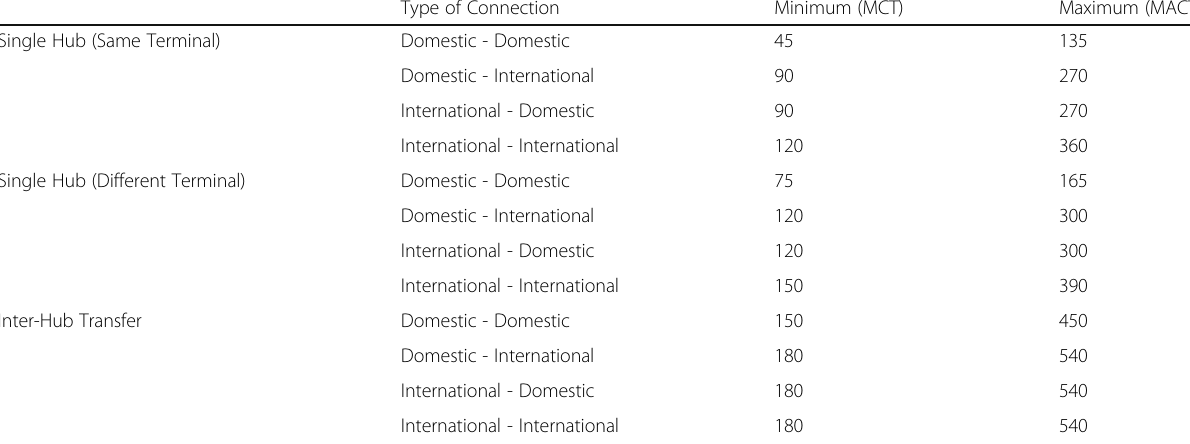
Table 1 Minimum and maximum connecting time for China Eastern Airlines in Pudong and Hongqiao Type of Connection Minimum (MCT) Maximum (MACT) Single Hub (Same